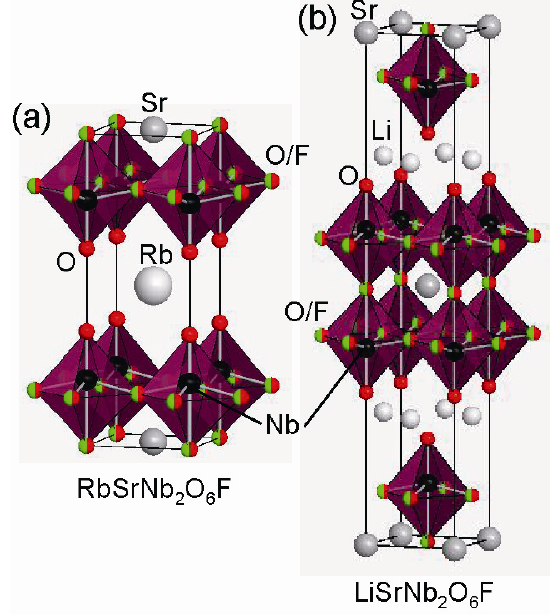
O F and ( b ) LiSrNb 2 6